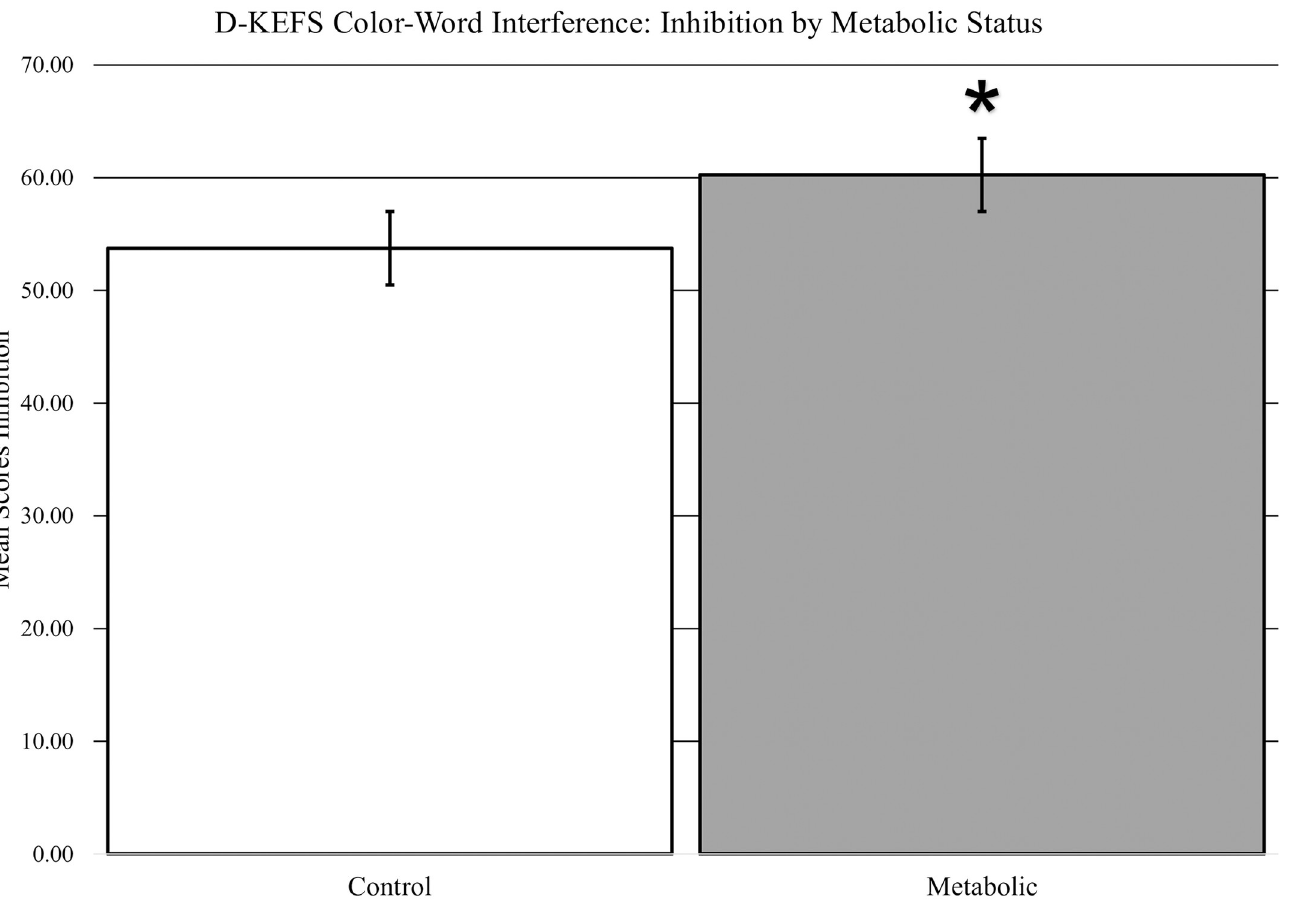
Fig 1. Main effect of metabolic syndrome on cognitive inhibition. � indicates p <